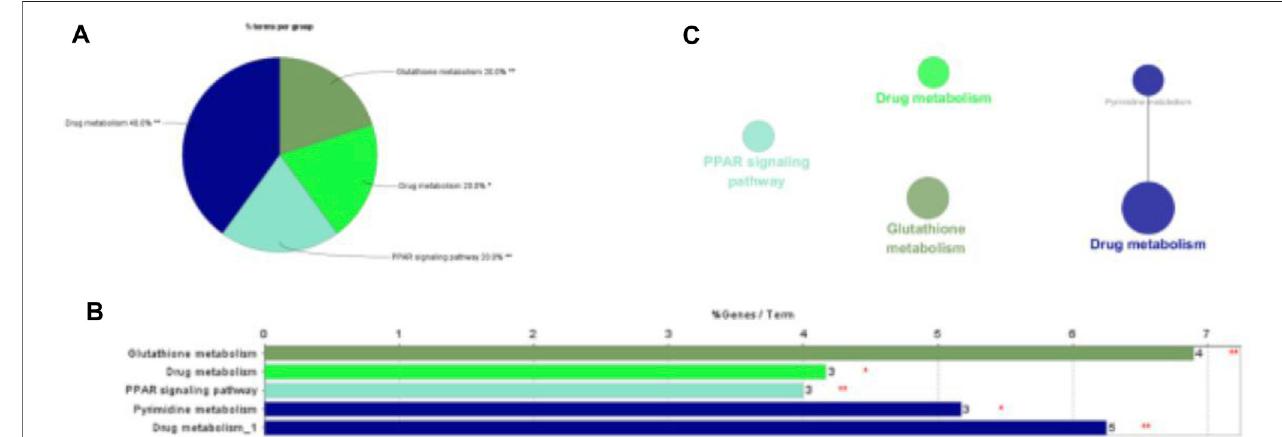
FIGURE 5 | KEGG pathway enrichment analysis in trastuzumab treated with breast cancer.